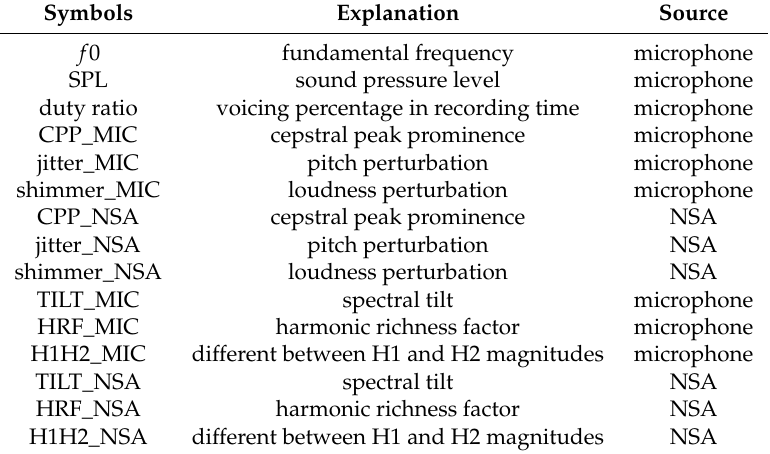
Table 2. List of features extracted from the microphone and NSA